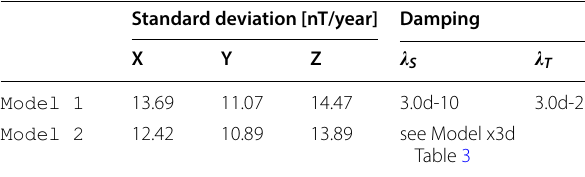
Table 1 Model diagnostics: residuals standard deviation in [nT/year] and damping parameters Standard deviation [nT/year] Damping